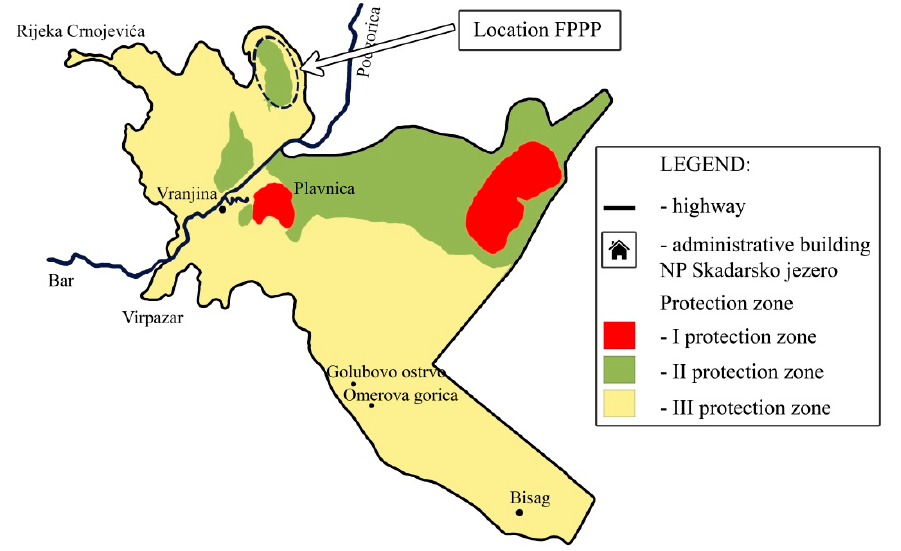
Figure 13. A map of zoning of the national park—SkadarLake.